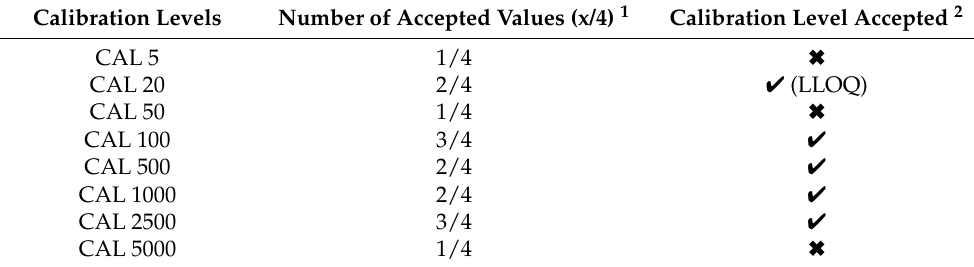
Table 3. Results for the creation of the calibration curve for the quantification of mebendazole (MBZ) in tissue sections using 2,5-dihydroxybenzoic acid (2,5-DHB) in tert-butyl methyl ether (TBME)/trifluoroacetic acid (TFA) 100:0.1 ( v / v ) with automatic motion.